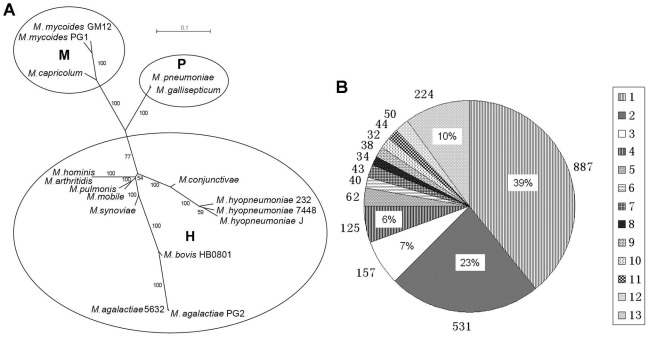
Phylogenetic Analysis and Orthologous Gene Detection.(A) Phylogenetic relationships of consensus sequences of 17 Mycoplasma strains with complete genomic sequences. The phylogenetic groups, mycoides, pneumoniae and hominis, are indicated by M, P and H, respectively. (B) Frequency of orthologous genes within the 13 genomes of different Mycoplasma species included in this analysis are listed in Table 1 (marked with *). The figures 1 to 13 on the right panel represent the number of genomes where the common orthologous genes were found. The rates in different parts of the circle represent the frequency of genes present in a single genome or shared by different genomes. The figures surrounding the circle represent orthologous gene numbers in individual parts. The 39% of genes including 887 present in a single genome represent lineage specific genes, while 10% of the genes including 224 were found in all 13 genomes, which represent the Mycoplasma core genome.